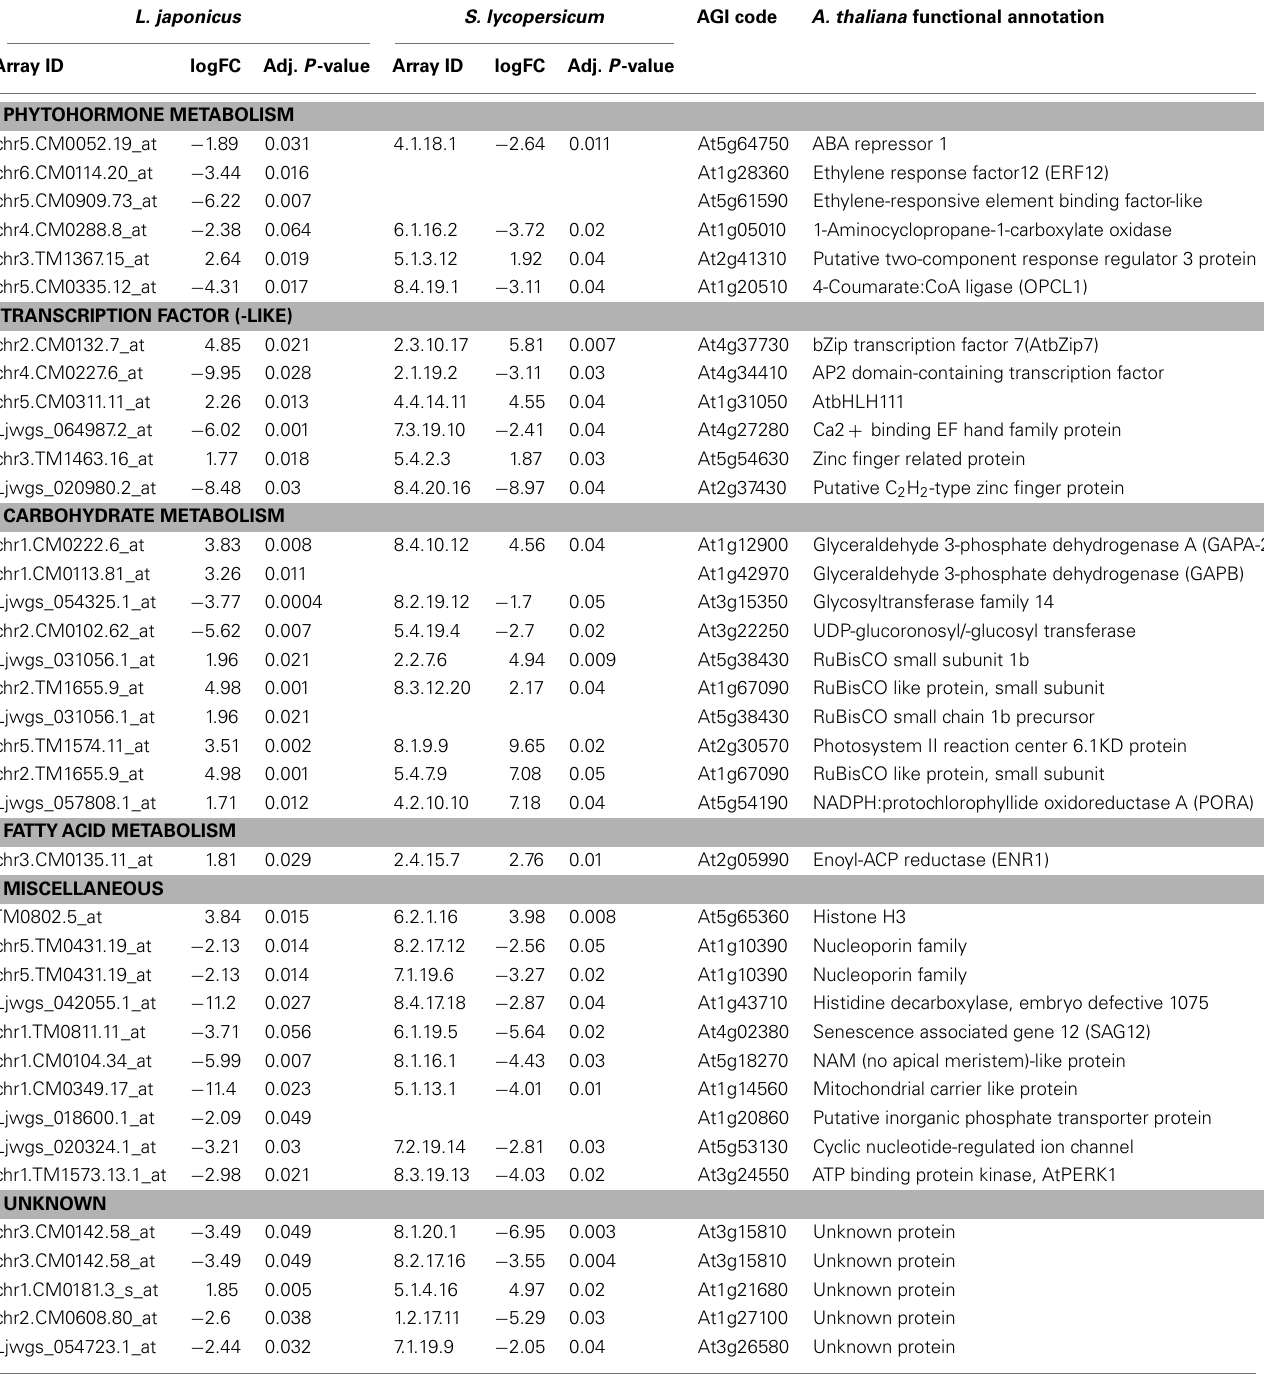
Table 1 | Orthologous gene comparisons between 5-week-old lumichrome-treated lotus ( L. japonicus ) and tomato ( S. lycopersicum )